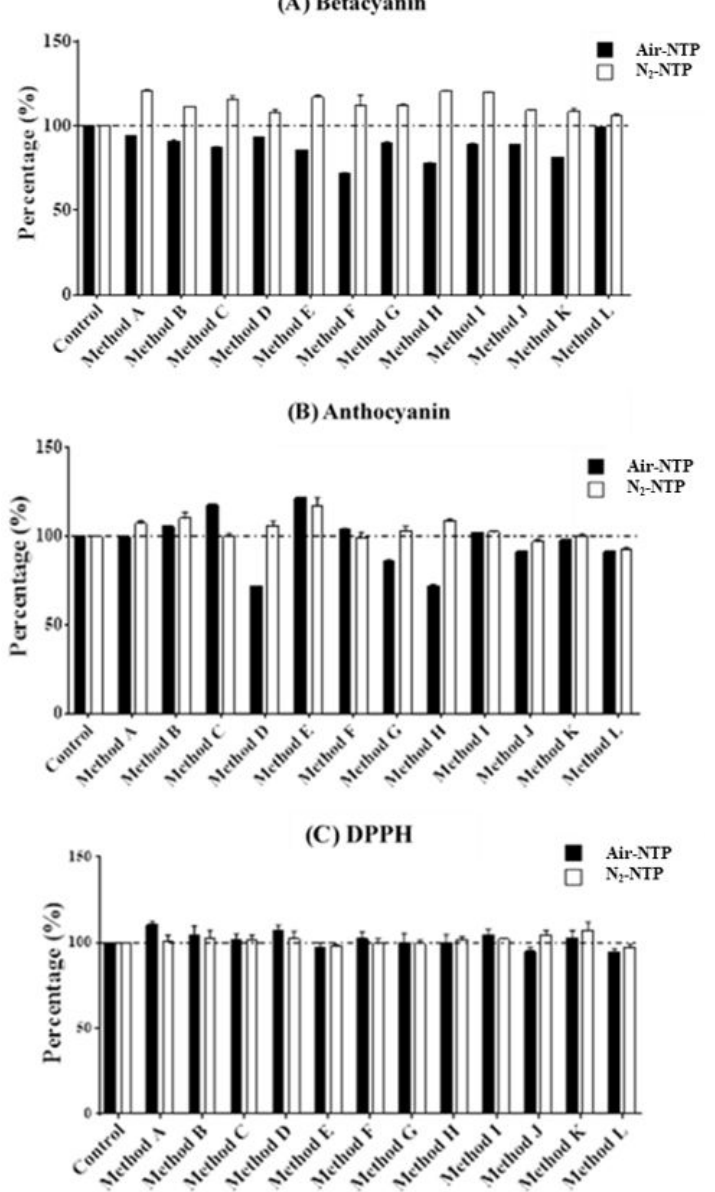
Figure 3. Variations in betacyanin ( A ), anthocyanin ( B ), and DPPH radical scavenging effects ( C ) in djulis seed after air-NTP or N 2 -NTP treatment compared with the untreated control. From Figure 4A, TPCs was significantly increased from 1.04 to 1.23 fold in all of the N 2 -NTP-treated seed and significantly increased (1.04–1.16 fold) in the air-NTP-treated seed with methods A, I, and J as compared with the untreated control ( p < 0.001). Figure 4B shows that, only method A in the air-NTP-treated seed and method B in the N 2 -NTP-treated seed showed significant increases in the TFs by 1.21 ( p < 0.01) and 1.01 ( p = 0.033) fold, respectively, compared with the untreated samples. The profiles for djulis extract are shown in Figures S4–S6. The most predominant compounds in TPCs and TFs were gallic